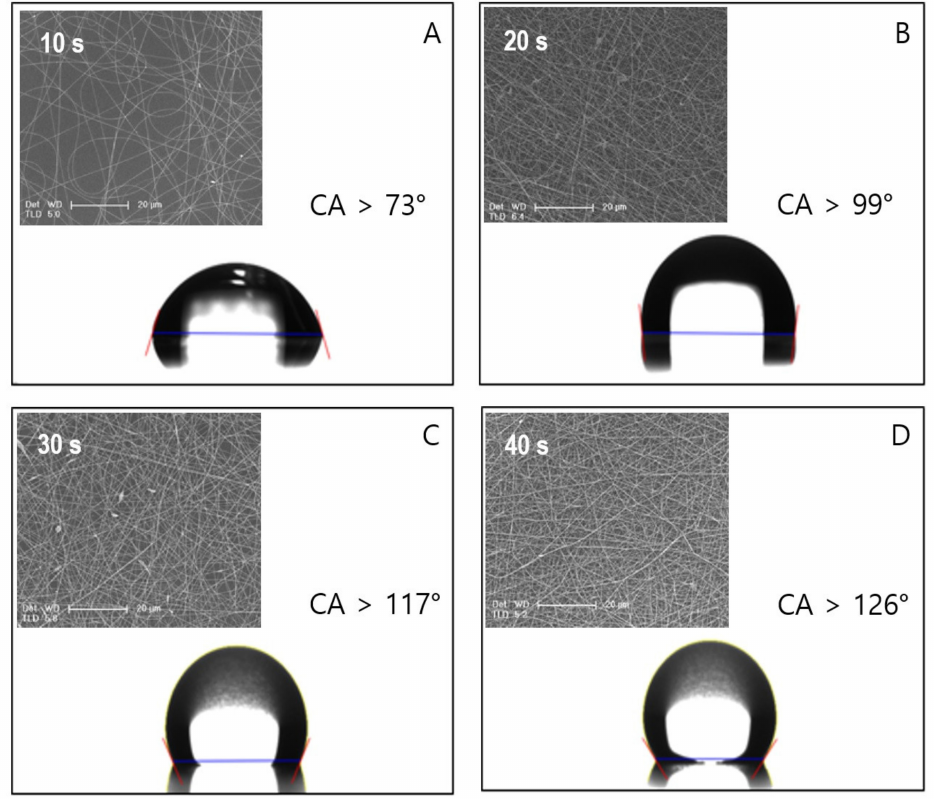
Figure 6. Water contact angle and SEM images of random networks of PS electrospun fibers deposited at ( A ) 10, ( B ) 20, ( C ) 30, and ( D ) 40 s. The applied voltage was 10 kV, and the working distance was 15